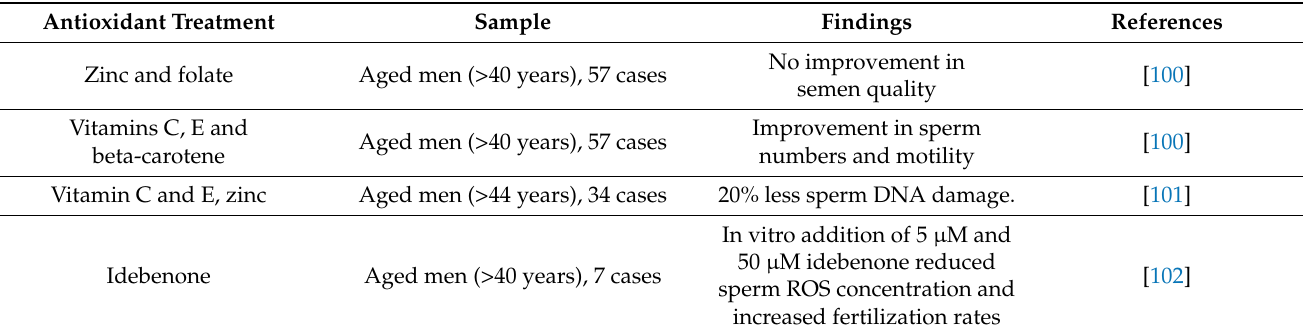
Table 2. Application of antioxidants in the treatment of aging